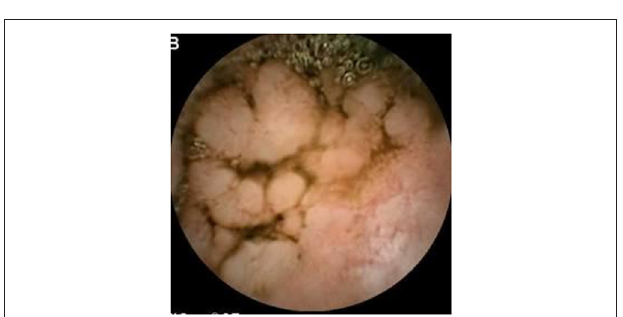
FIGURE 14 | Lymphoid